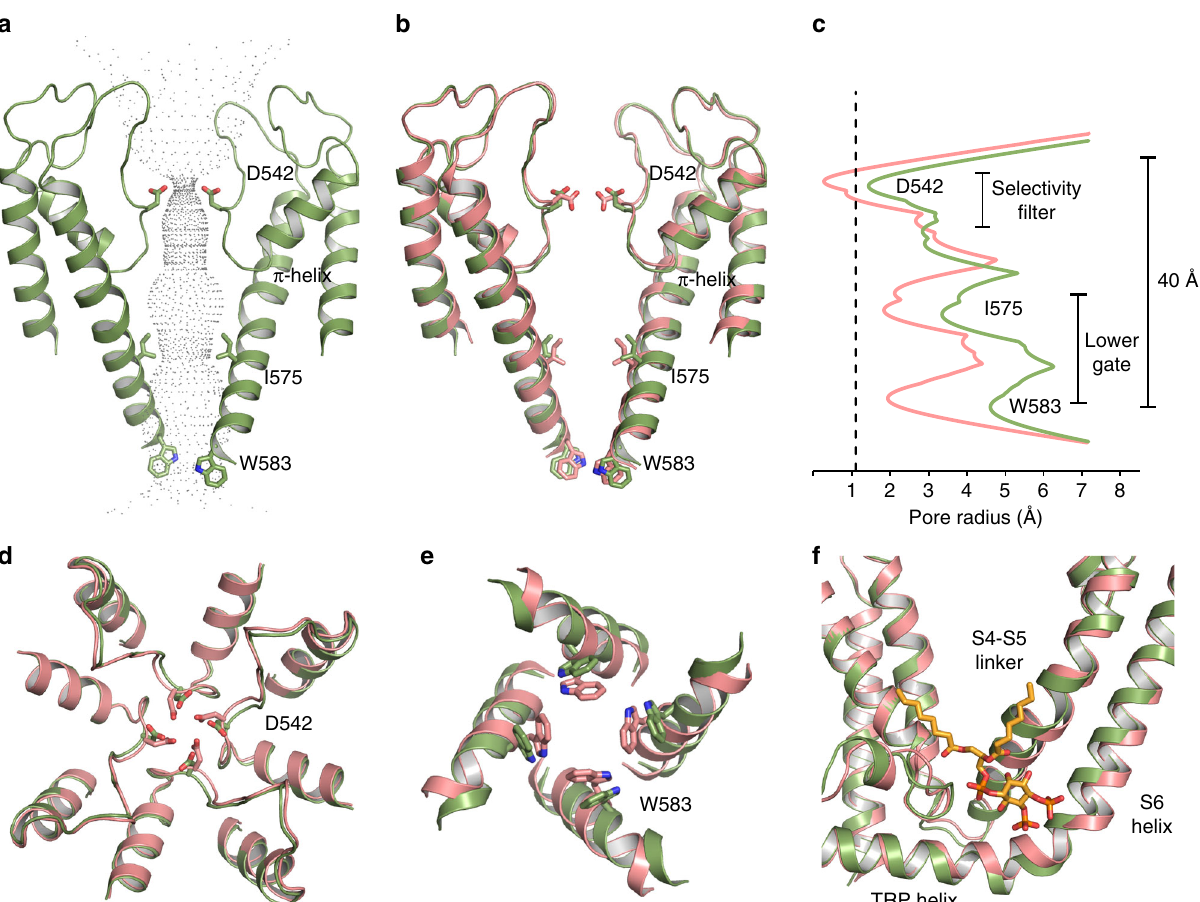
Fig. 3 Comparison between lipid-bound and PI(4,5)P 2 -bound TRPV5. a The pore diagram of PI(4,5)P 2 -bound TRPV5 is shown in green. b Lipid-bound TRPV5 (pink) superimposed onto the PI(4,5)P 2 -bound (green) pore diagram shows a slight shift in the S6 helices and important gating residues originating at the π -helix. c Plot of pore radii of lipid-bound TRPV5 (pink) and PI(4,5)P 2 -bound TRPV5 (green) as a function of distance through the pore. The dotted line indicates the radius of a calcium ion. d Extracellular view of the tetrameric selectivity fi lter of lipid-bound (pink) and PI(4,5)P 2 -bound TRPV5 (green). e Intracellular view of the tetrameric lower gate of lipid-bound (pink) and PI(4,5)P 2 -bound TRPV5 (green). f Zoomed-in view of the overlayed TMDs of lipid-bound (pink) and PI(4,5)P 2 -bound TRPV5 (green). DiC 8 PI(4,5)P 2 is shown in orange